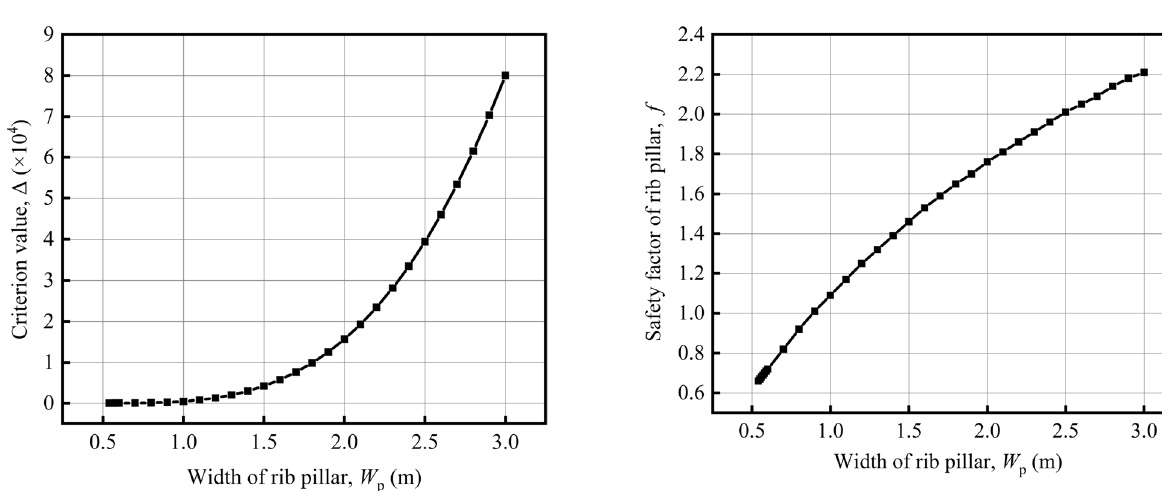
Fig. 15 Mechanical criterion value Δ of the rib pillar instability under dynamic and static loads of the No. 1 haulage bench